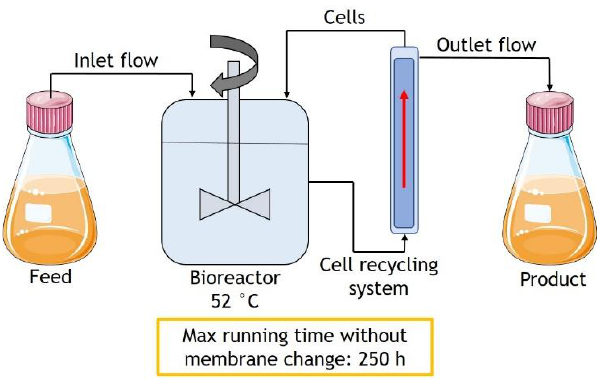
Figure 6. Schematic representation of the continuous fermentation system with cell retention.